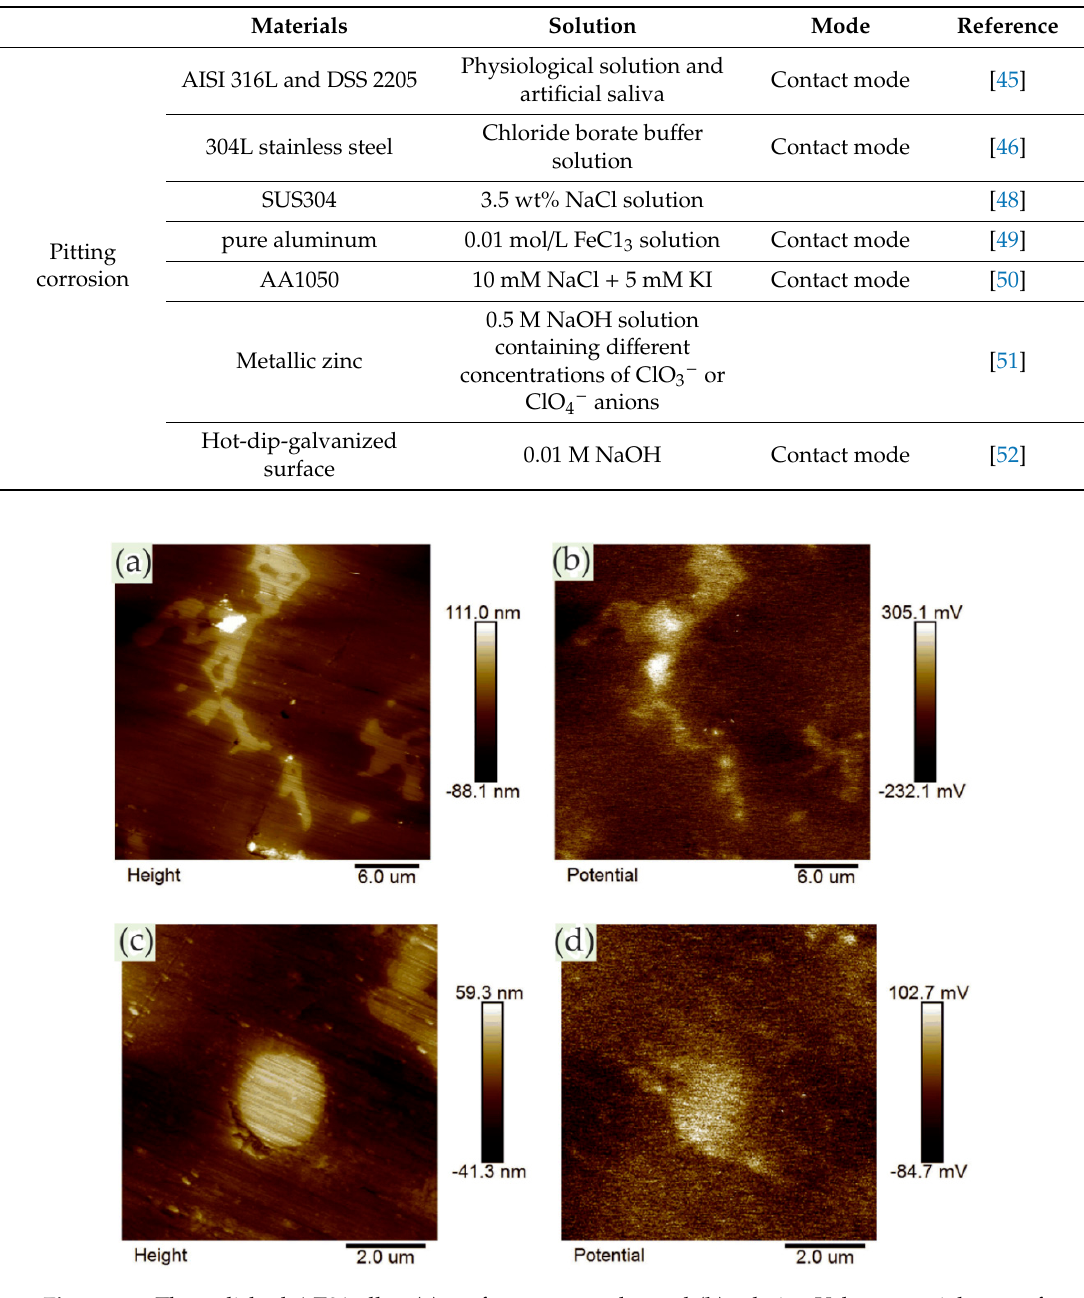
Figure 17. The polished AZ91 alloy ( a ) surface topography and ( b ) relative Volta potential map of elongated b-Mg 17 Al 12 ; ( c ) surface topography and ( d ) relative Volta potential map of granular-like b-Mg 17 Al 12 . Reprinted with permission from Reference [53]; copyright 2019 Elsevier Ltd.